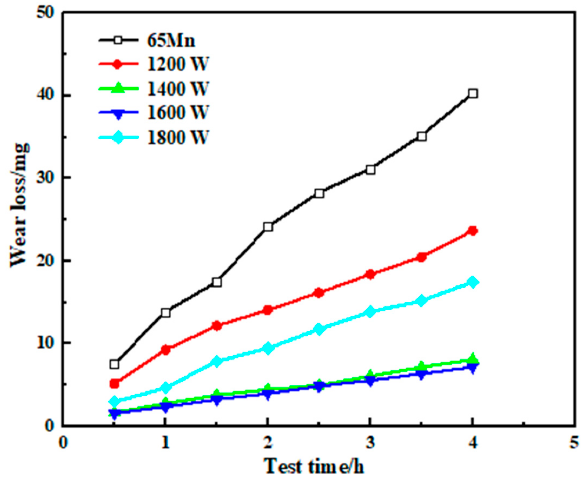
Figure 12. Contrast of the wear loss of the specimen.